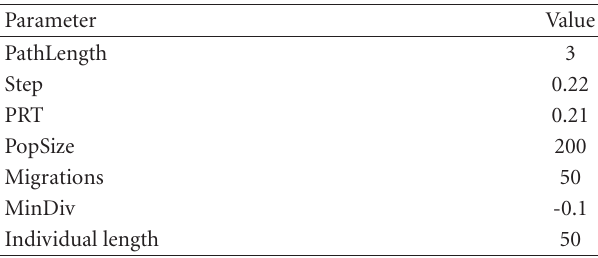
Table 1: Setting of SOMA.